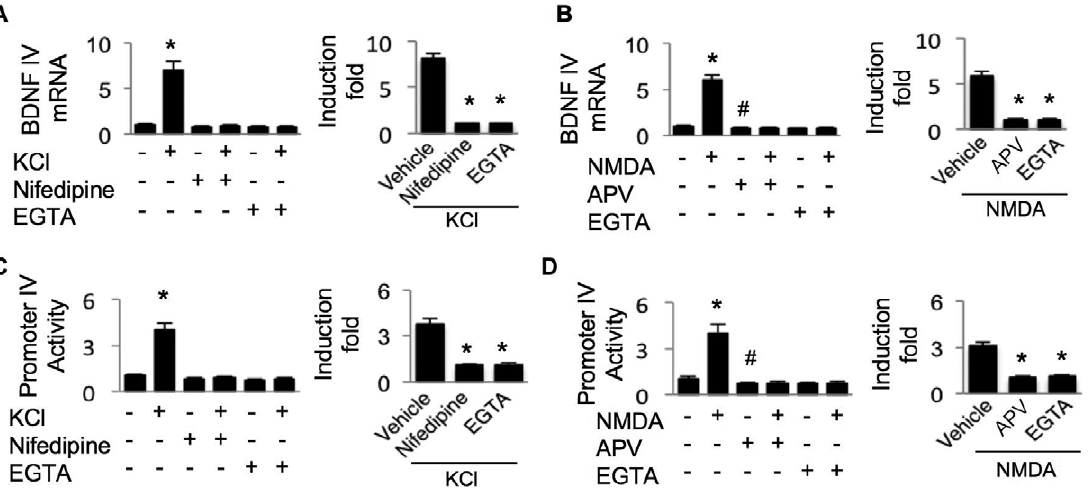
Figure 1. KCl and NMDA stimulate BDNF IV mRNA transcription and PIV-luciferase activity through L-VGCC and NMDAR. For (A) and (B), DIV 14 cortical neurons were treated with 50 mM KCl (A) or 20 m M NMDA (B) for one hour. L-VGCC blocker nifedipine (10 m M), or NMDAR antagonist APV (100 m M), or extracellular calcium chelator EGTA (2.5 mM) was added 30 min before the stimulation. After the one-hour incubation with NMDA or KCl, samples were collected and total RNA was extracted. The extracted RNA was reverse transcribed to cDNA, and then analyzed by real-time PCR. The level of BDNF IV mRNA was normalized to that of GAPDH mRNA. For (C) and (D), DIV 9 cortical neurons were transfected with promoter IV-luciferase reporter and TK-pRL plasmid. Two days after transfection (i.e. on DIV 11), neurons were treated with 50 mM KCl (C) or 20 m M NMDA (D). To pharmacologically block L-VGCC, or NMDAR, or chelate extracellular calcium, neurons were pre-treated with nifedipine, or APV, or EGTA, respectively. After six-hour incubation with KCl or NMDA, dual luciferase assay was performed. The firefly luciferase activity was normalized to Renilla-luciferase. In the left panels, ‘‘*’’ indicates statistical difference to all other groups, and ‘‘ # ’’ indicates significant difference to the naı¨ve group not treated with any drug. In the right panels, the effect of drugs on KCl- or NMDA-stimulated fold induction of transcription was normalized to the drug-only group (*: statistically different to that of the KCl- or NMDA-stimulated transcription in neurons not treated with nifedipine, or APV, or EGTA). Data were collected from 4 independent preparations for each treatment. All neurons in A and C were pre-treated with CNQX and APV. All neurons in B and D were pre-treated with CNQX and nifedipine.